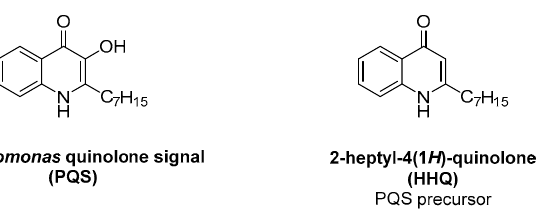
Scheme 3. AIs of pqs system: the 2-heptyl-3-hydroxy-4(1 H )-quinolone (PQS) and the 2-heptyl-4(1 H )- quinolone